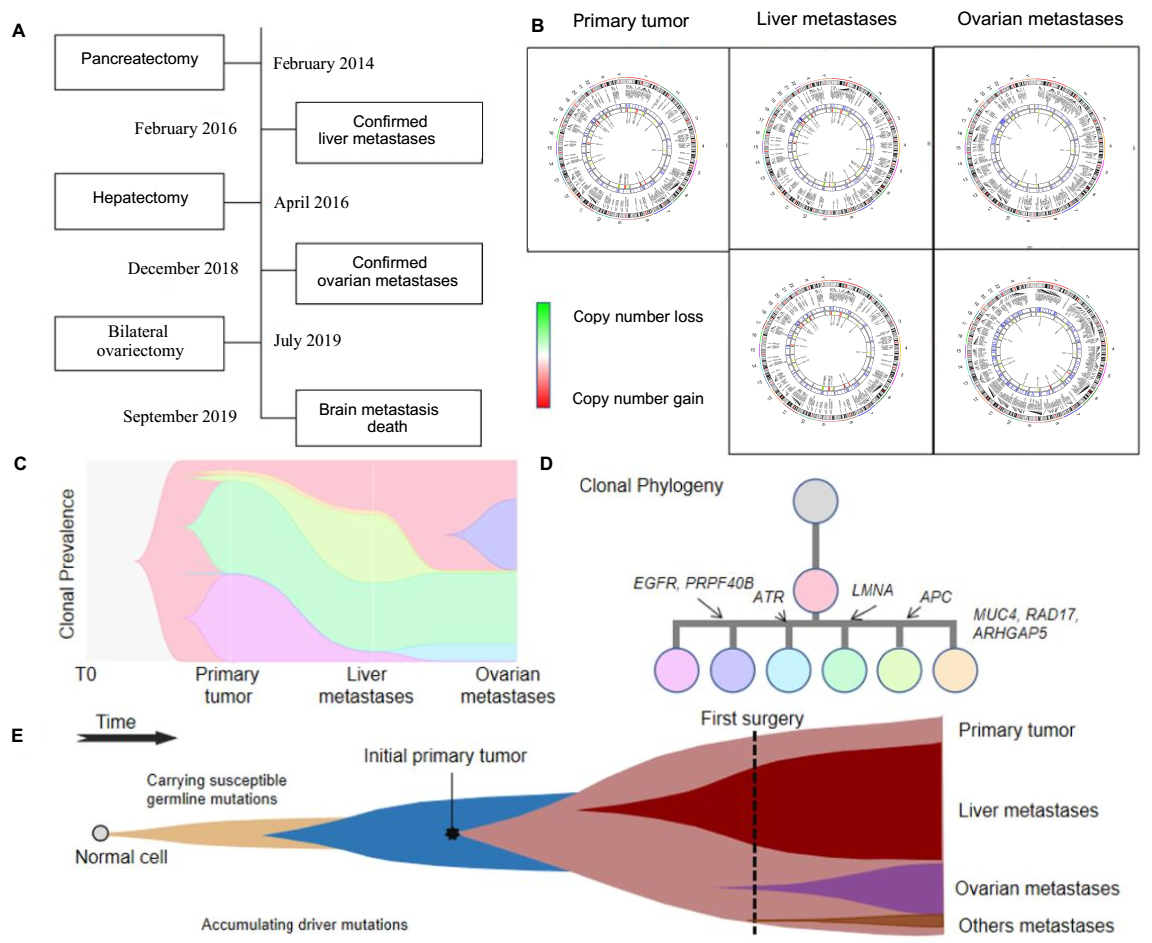
Figure 3. Evolutionary trajectories of PanNETs in a patient with liver and ovarian metastases. ( A ) Case No.11 underwent three operations within five years to remove the primary tumor, liver metastases, and ovarian metastases, respectively. Her five tumor samples and blood were whole-exome sequenced. ( B ) Circos plots display the chromosomal distribution of variations in the five tumor samples from the patient. The outer rings indicate SNVs and the inner rings indicate copy number variations (CNVs). The high-resolution version of the circos plots can be found in Supple- mentary Figure S1. ( C ) The dynamic diagram of clonal prevalence during the dissemination from primary PanNET to the liver and ovarian. ( D ) Tumor phylogenies are reconstructed based on somatic variations of the patient. ( E ) Schematic illustration of tumor evolution: starting with normal cells that carry susceptible germline mutations, more and more driving mutations are accumulated as the cells proliferate, leading to malignant transformation, growth of the primary tumor and metastatic dissemination, seeding and